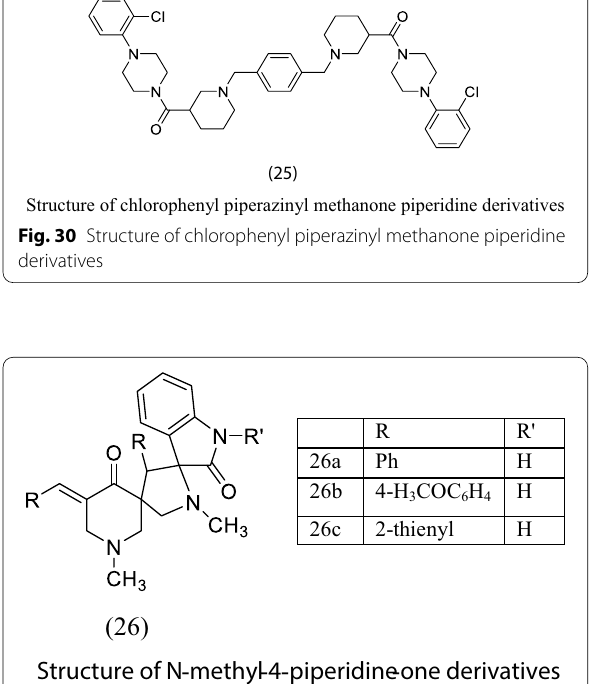
Fig. 31 Structure of N‑methyl‑4‑piperidine‑one derivatives